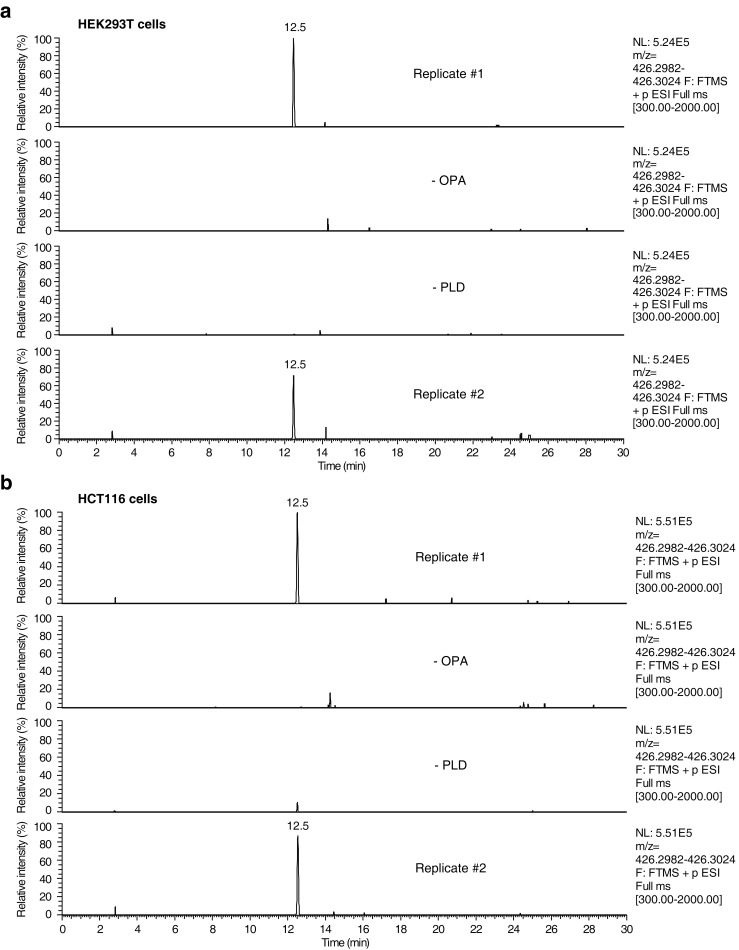
Raw data and replicate experiment for data represented in Figure 4c–d.Extracted ion chromatograms (m/z = 426.2982–426.3024) showing the detection of phosphatidylethanolamine-ophiobolin A (PE-OPA) adducts in lipids extracted from cells treated with OPA. (a) HEK293T cells grown in standard conditions were incubated with 250 nM OPA for 24 hr. Total cellular lipids were extracted in the presence of pentyl-pyridoxamine to quench unreacted OPA and prevent any post-lysis reaction. Lipids were then incubated with phospholipase D (PLD) and analyzed by LC-MS for presence of Etn-OPA. Negative controls include replacement of OPA by DMSO vehicle (- OPA) or absence of PLD treatment (- PLD). (b) Same as (a) but for HCT116 cells treated with 450 nM OPA. Extracted ion intensity levels ('NL') were normalized to the peak of highest intensity.